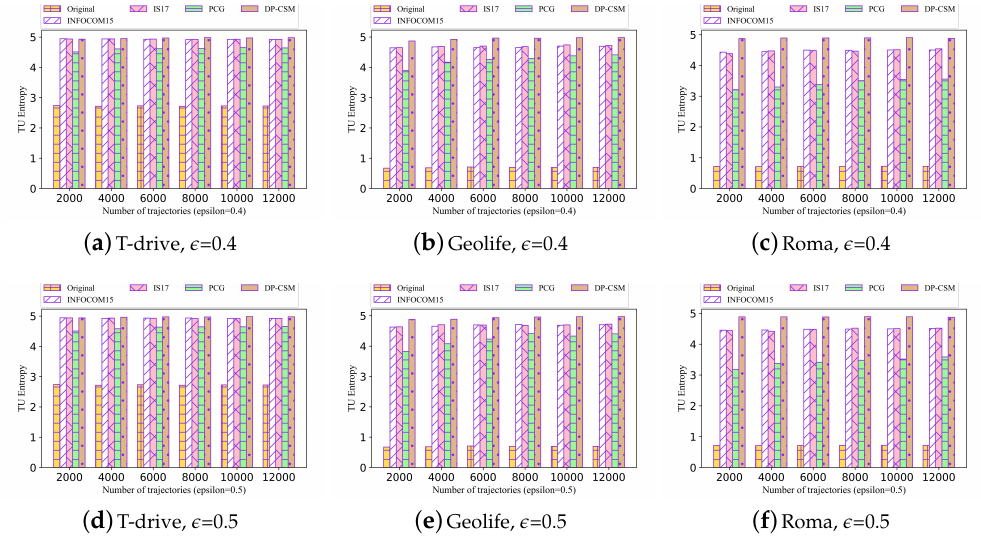
Figure 8. The temporal-uncorrelated entropy comparison of the four models under different settings. In particular, we fix k = 80, and varies privacy budget (cid:101) and the size of trajectory datasets. For the privacy budget, we choose two kinds of values, i.e., (cid:101) = 0.4 and (cid:101) = 0.5, respectively. Under each privacy budget, we vary the sizes of trajectory datasets.